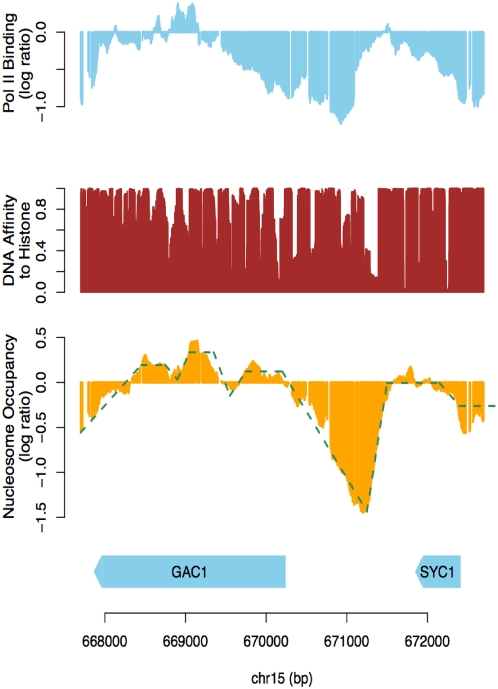
Histones are depleted from the promoter of gene GAC1 prior to its activation.This figure shows the RNA polymerase II binding (log ratio from our ChIP-chip results), DNA affinity for histone (posterior probability of histone binding from Segal et al. [11]), and nucleosome occupancy (log ratio from our ChIP-chip results) around gene GAC1 in rich medium.